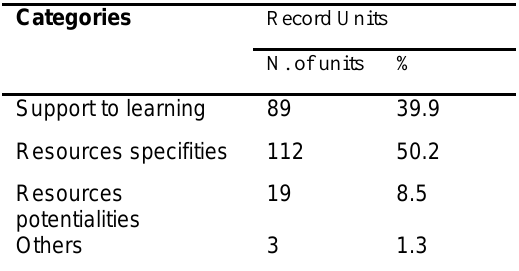
Table 7. Classification of digital